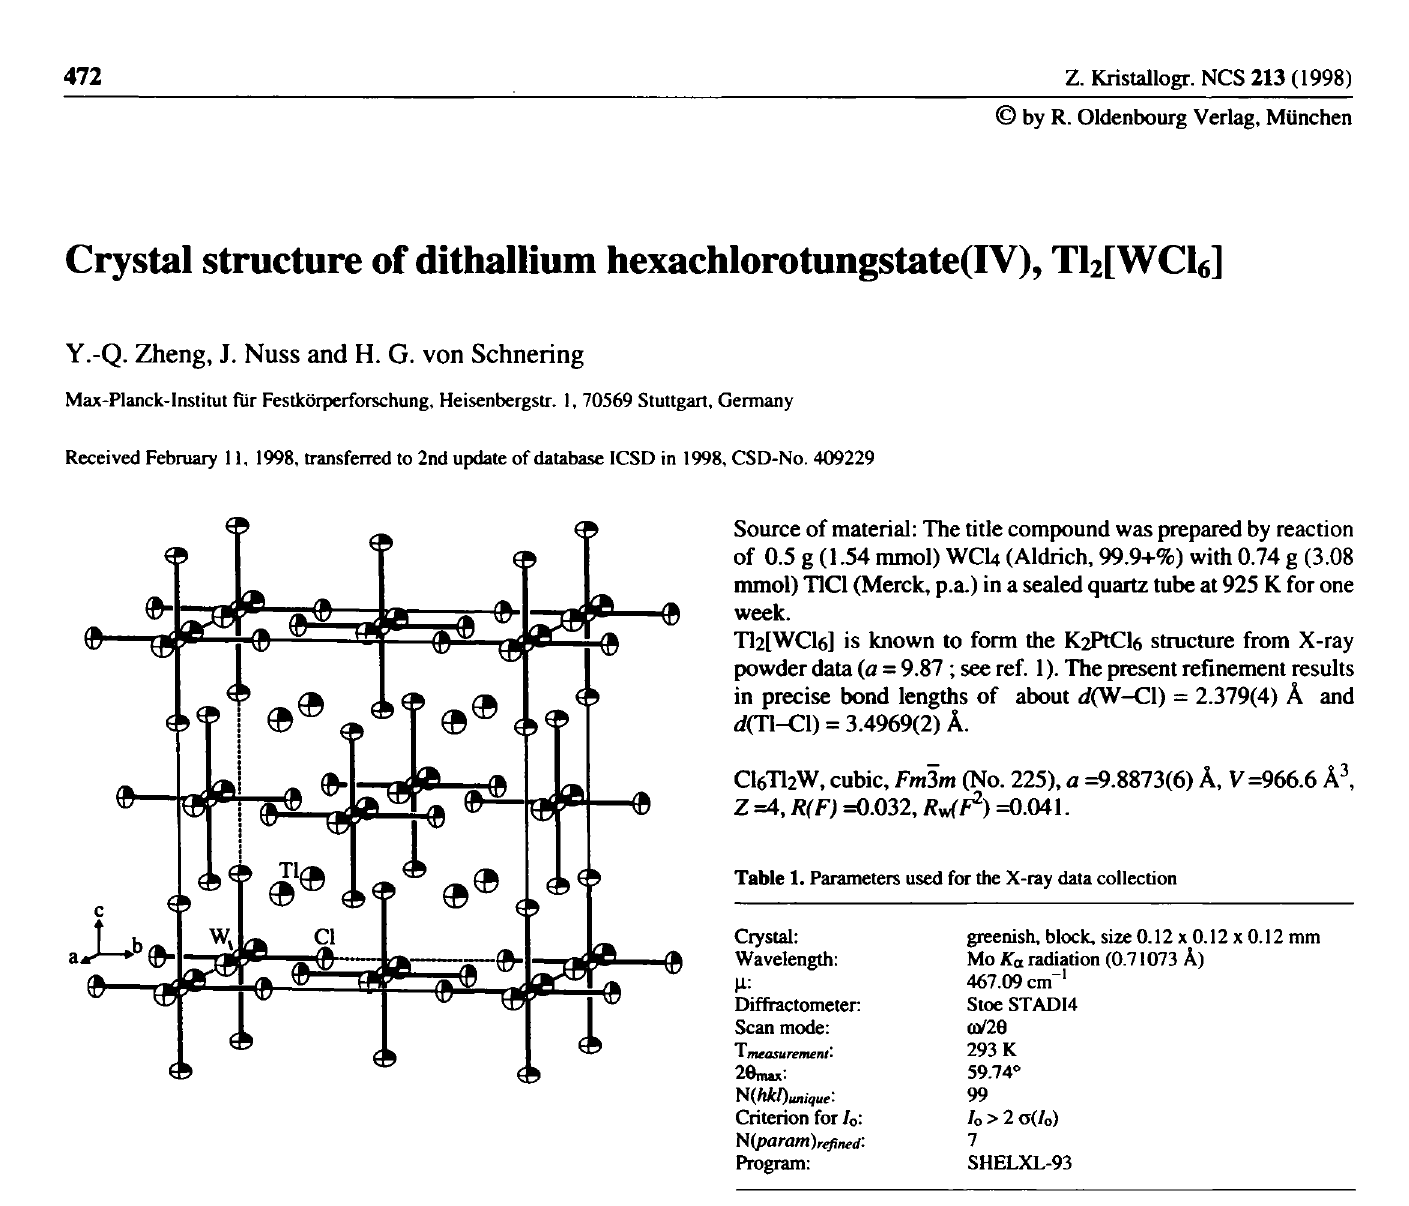
Table 2. Final atomic coordinates and displacement parameters (in Â^) Atom